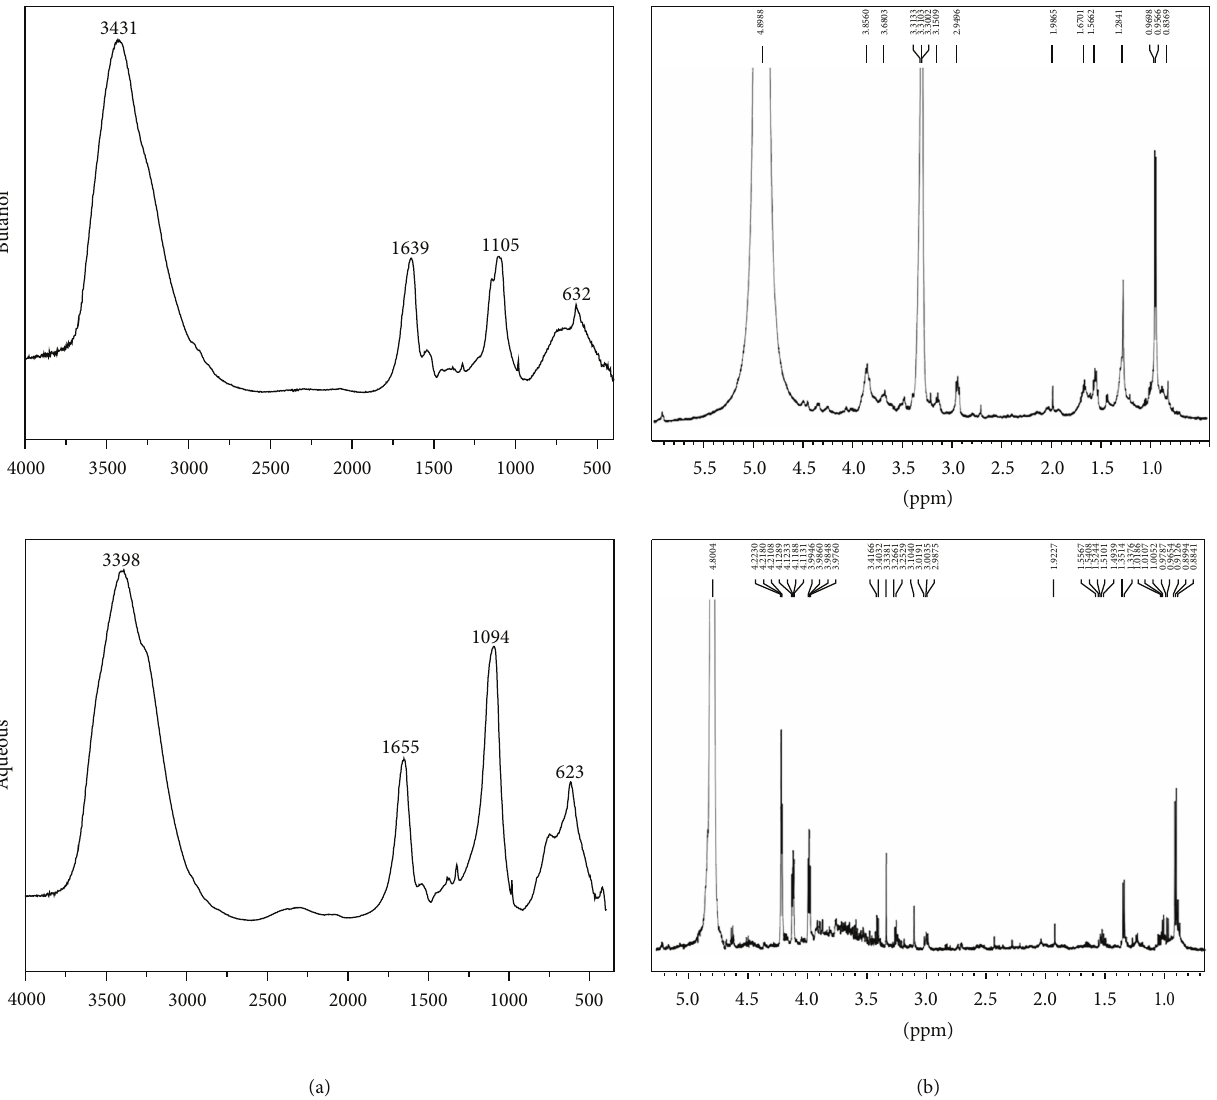
Figure 1: Fingerprinting analysis for C. procera latex fractions through infrared spectroscopy (left panel) and 1 H-RMN (right